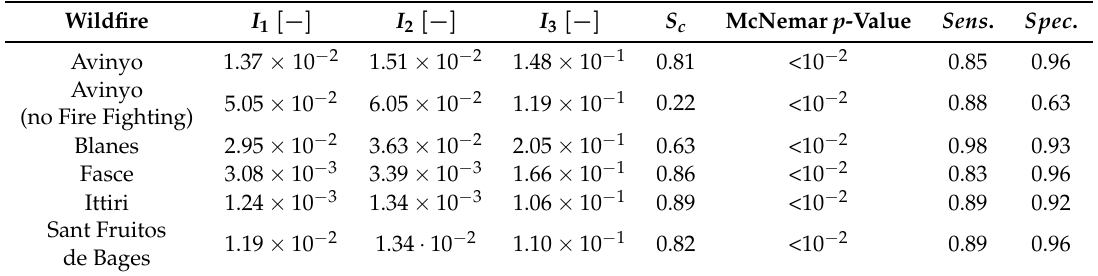
Table 4. Performance of the simulation of the proposed test